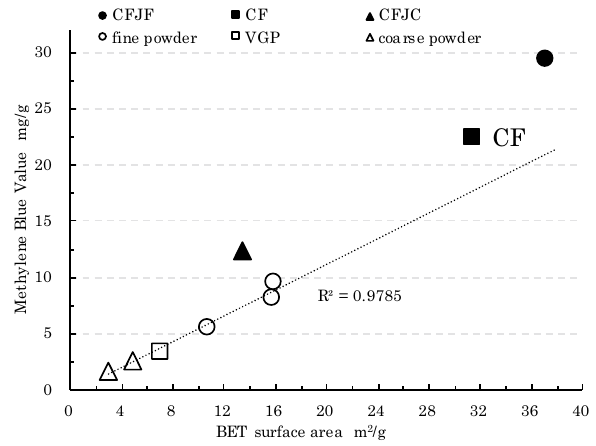
Fig. 14 Relationship between BET surface area and MB adsorption of VGP and Clay powder